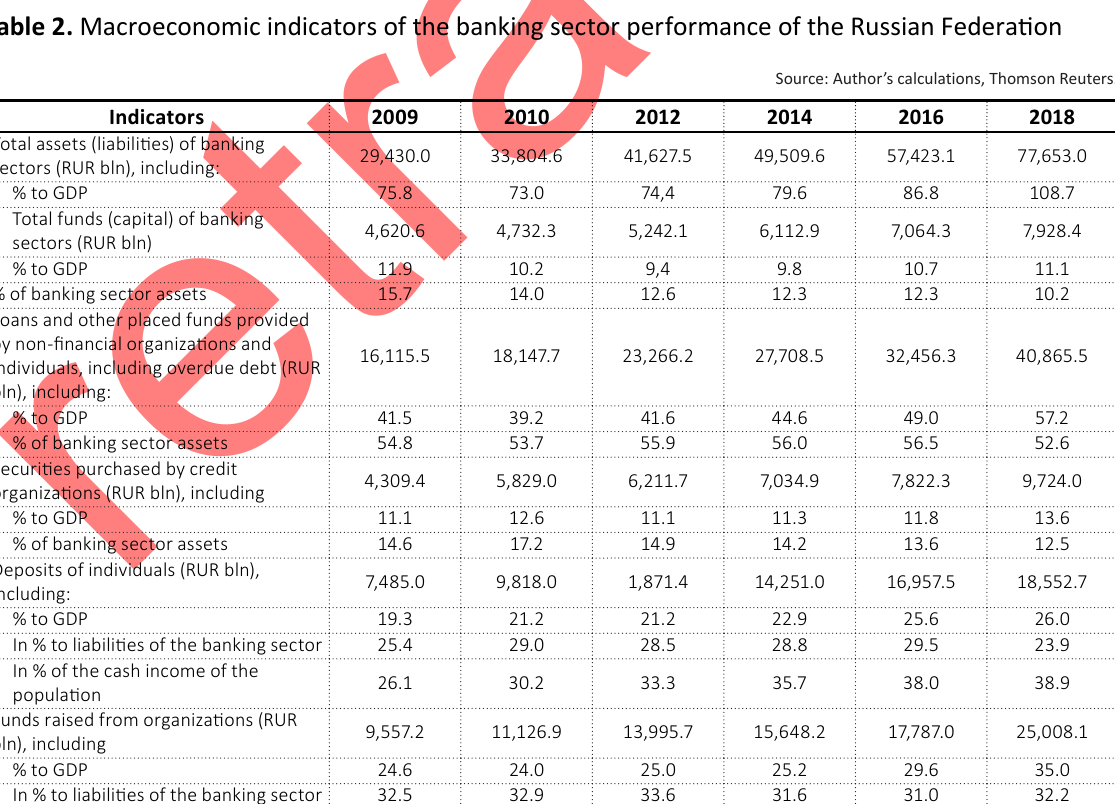
Table 2. Macroeconomic indicators of the banking sector performance of the Russian Federation